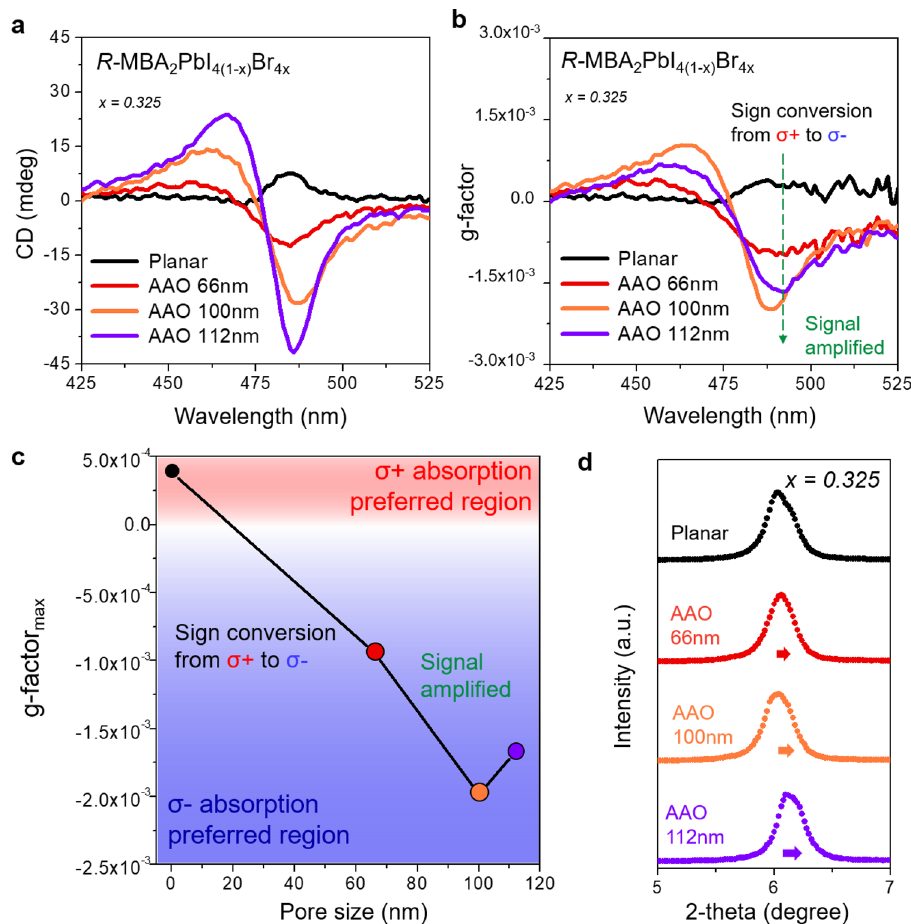
Fig. 1 Chiroptical activity and in-depth structural studies of chiral 2D OIHPs grown under different substrate conditions. a CD spectra of chiral 2D OIHPs thin fi lms, ( b ) calculated g-factor from the CD spectra, and ( c ) plot of local maximum g-factor at the fi rst extinction band edge as a function of AAO pore sizes. d thin- fi lm XRD patterns of chiral 2D OIHPs grown on different substrate conditions with bromide composition of x =